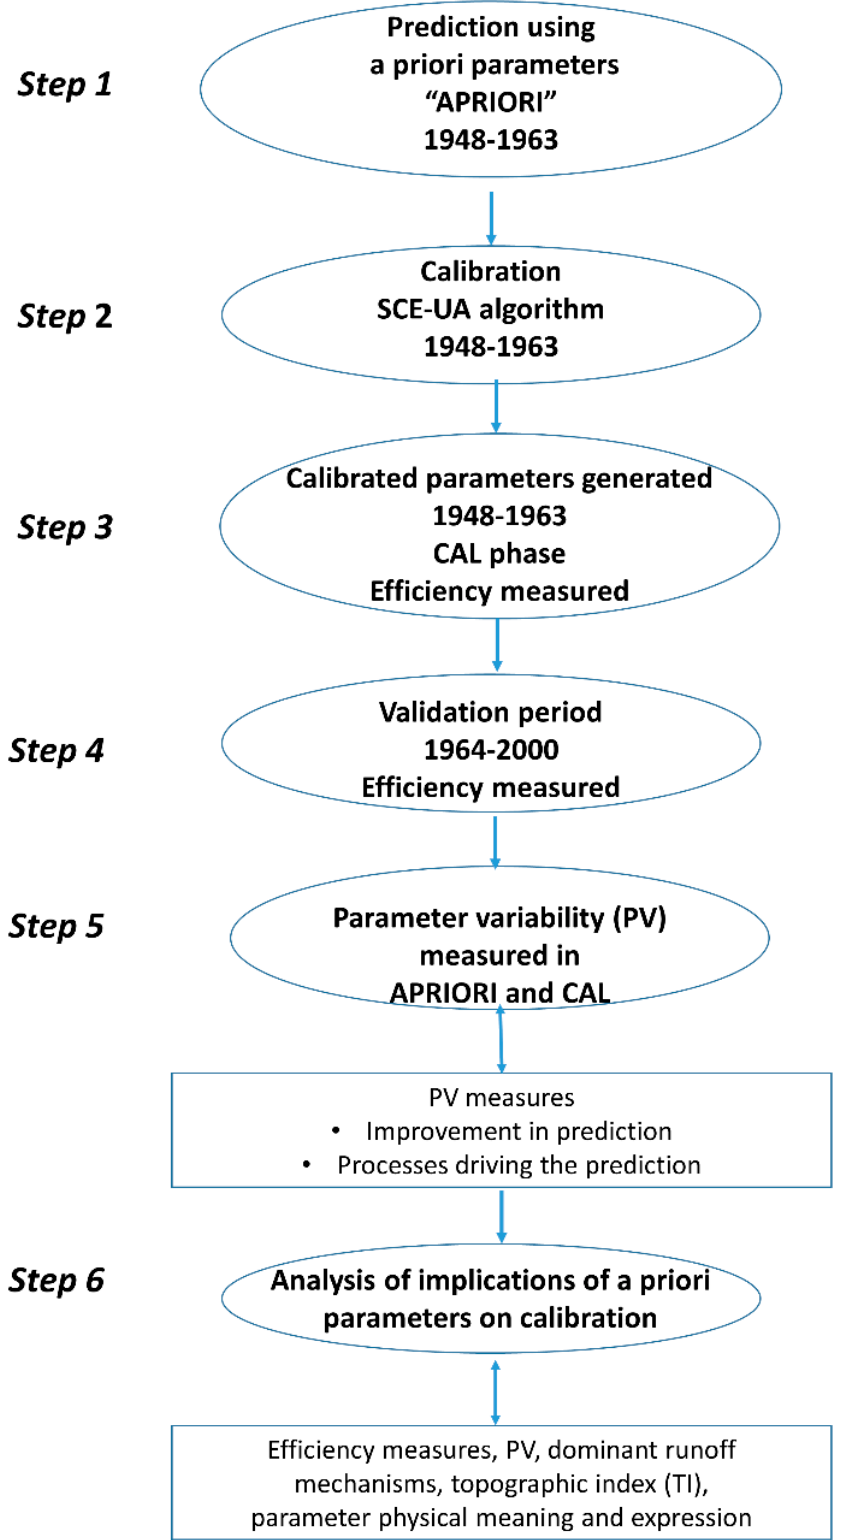
Figure 2. Steps of the analysis. PV stands for parameter variability. APRIORI stands for simulation using a priori parameters. CAL stands for simulation using the calibrated parameters. Both CAL and APRIORI phases used data between 1948 and 1963.